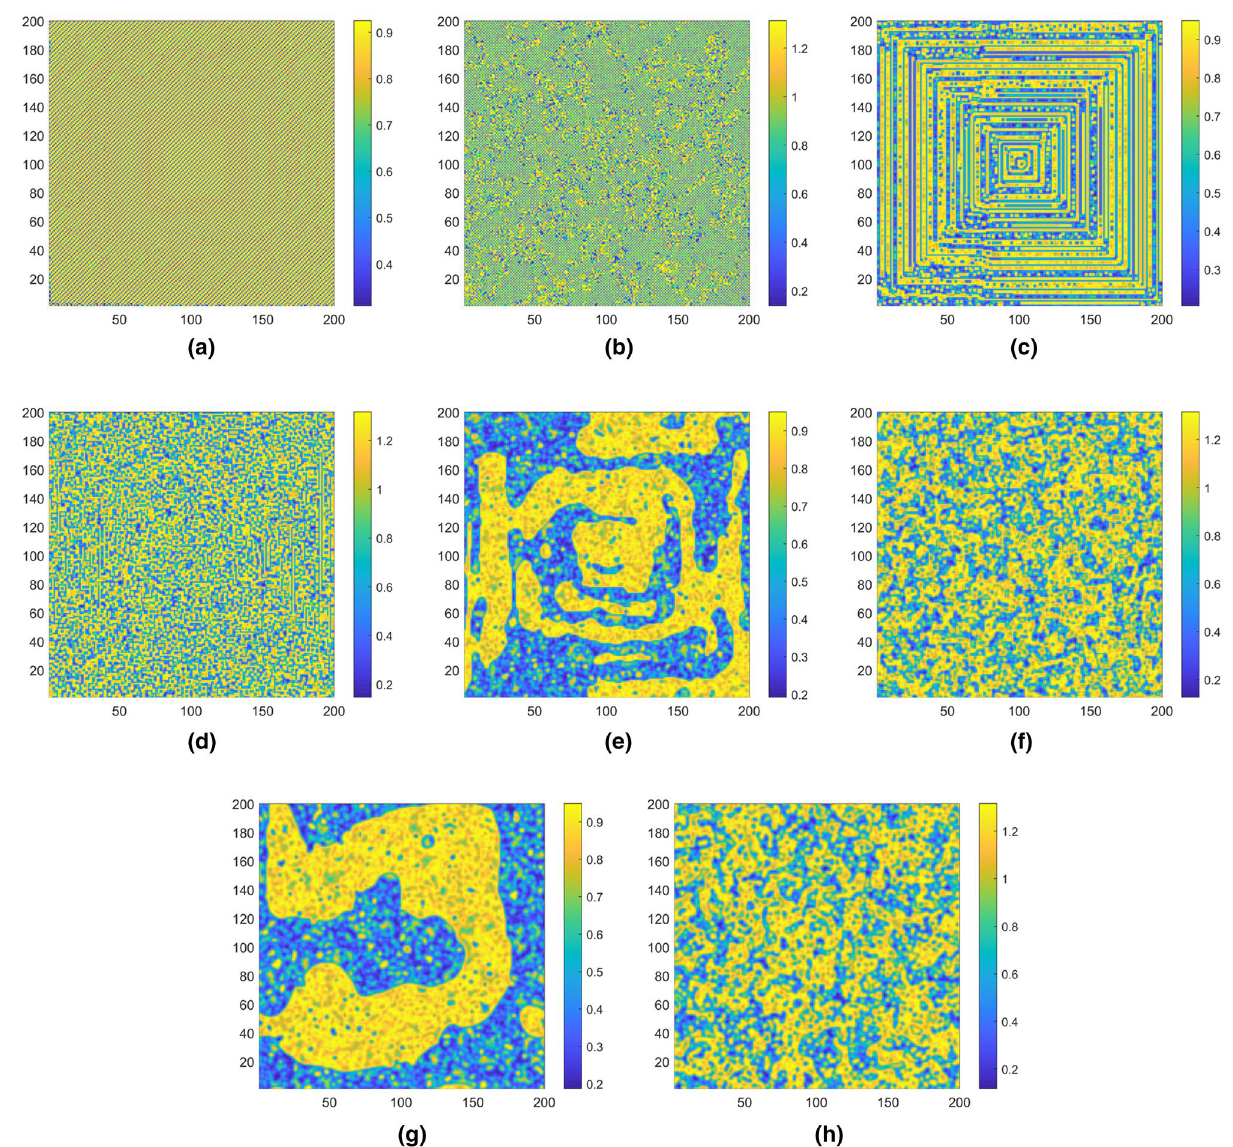
Figure 7. Snapshot patterns when times = 1000. ( a ) the 2DCML system ( ε = 0.1), ( b ) the proposed system ( ε = 0.1), ( c ) the 2DCML system ( ε = 0.3), ( d ) the proposed system ( ε = 0.3), ( e ) the 2DCML system ( ε = 0.5), ( f ) the proposed system ( ε = 0.5), ( g ) the 2DCML system ( ε = 0.7), ( h ) the proposed system ( ε =